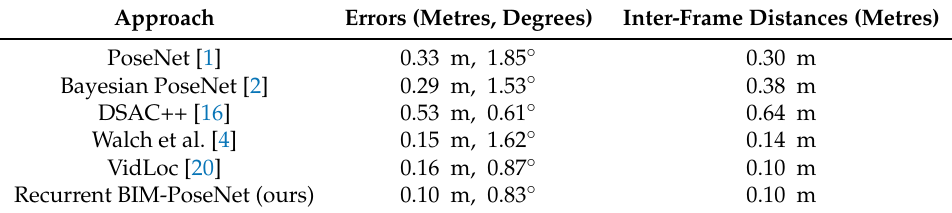
Table 1. The comparison of the median errors and inter-frame distances of different approaches.